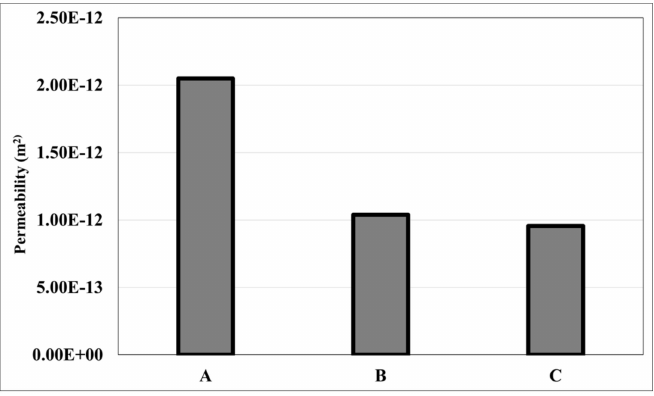
Figure 6. Permeability of the furan samples